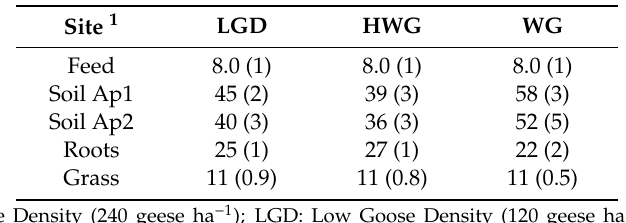
Table 5. Copper concentration in the feed, soil (horizons Ap1 and Ap2), and di ff erent plant portions (mg / kg) of the vineyard soils with a high and low geese density, and of the soil of the control vineyard. Numbers in parentheses are the standard errors ( n =